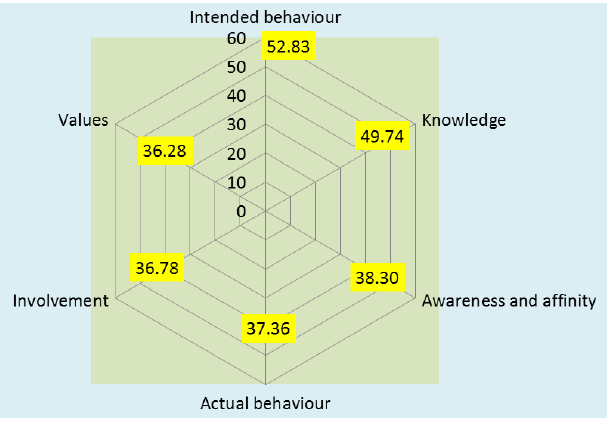
Figure 1: Avi-tourism literacy rates by